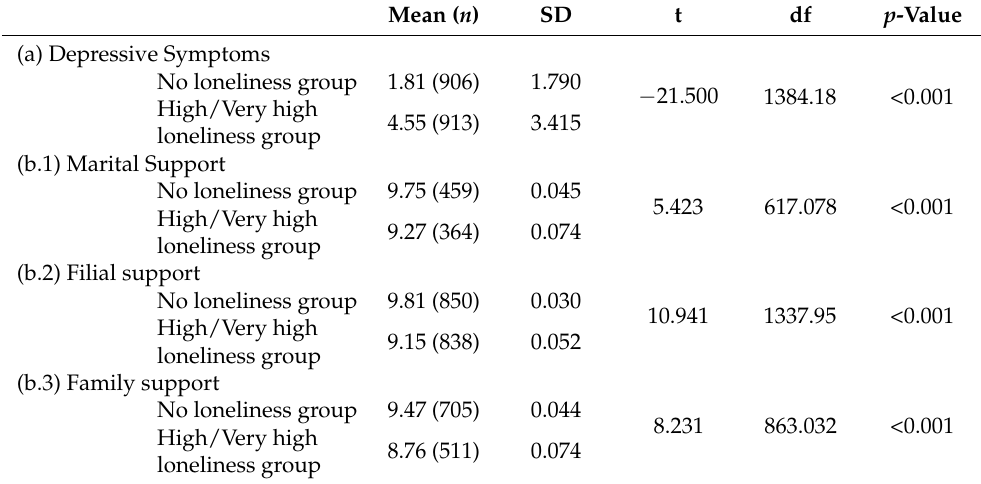
Table 7. Mean differences in Depressive Symptoms and Social Support between the Loneliness groups. Mean ( n ) SD t df p